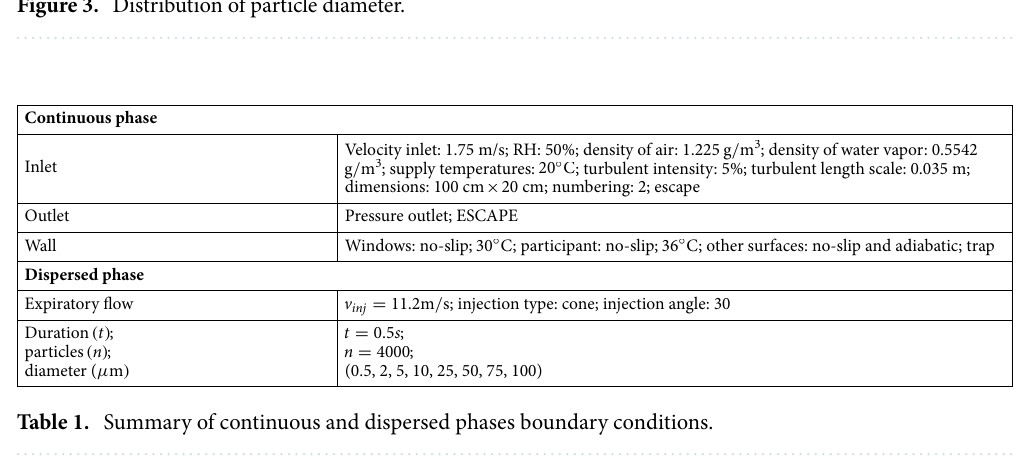
Figure 3. Distribution of particle diameter.